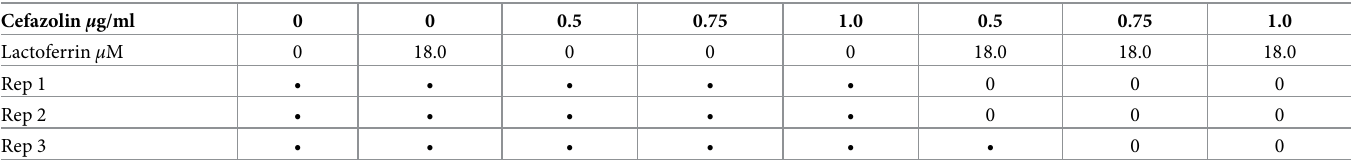
Table 3. CFU counts from experimental treatment of Xen36 bacteria. Cells with • indicate too many CFU’s to count. Cefazolin μ